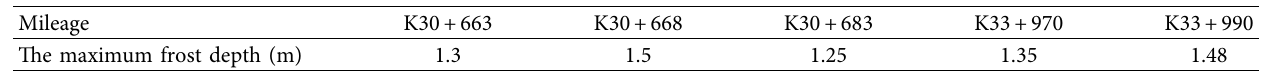
Figure 10: The radial temperature distribution of surrounding rock in February and July. (a) Section K30+668. (b) Section K31+ 536. (c) Section K33 +218. (d) Section K33+970. Table 4: The maximum freeze depth in the tunnel.